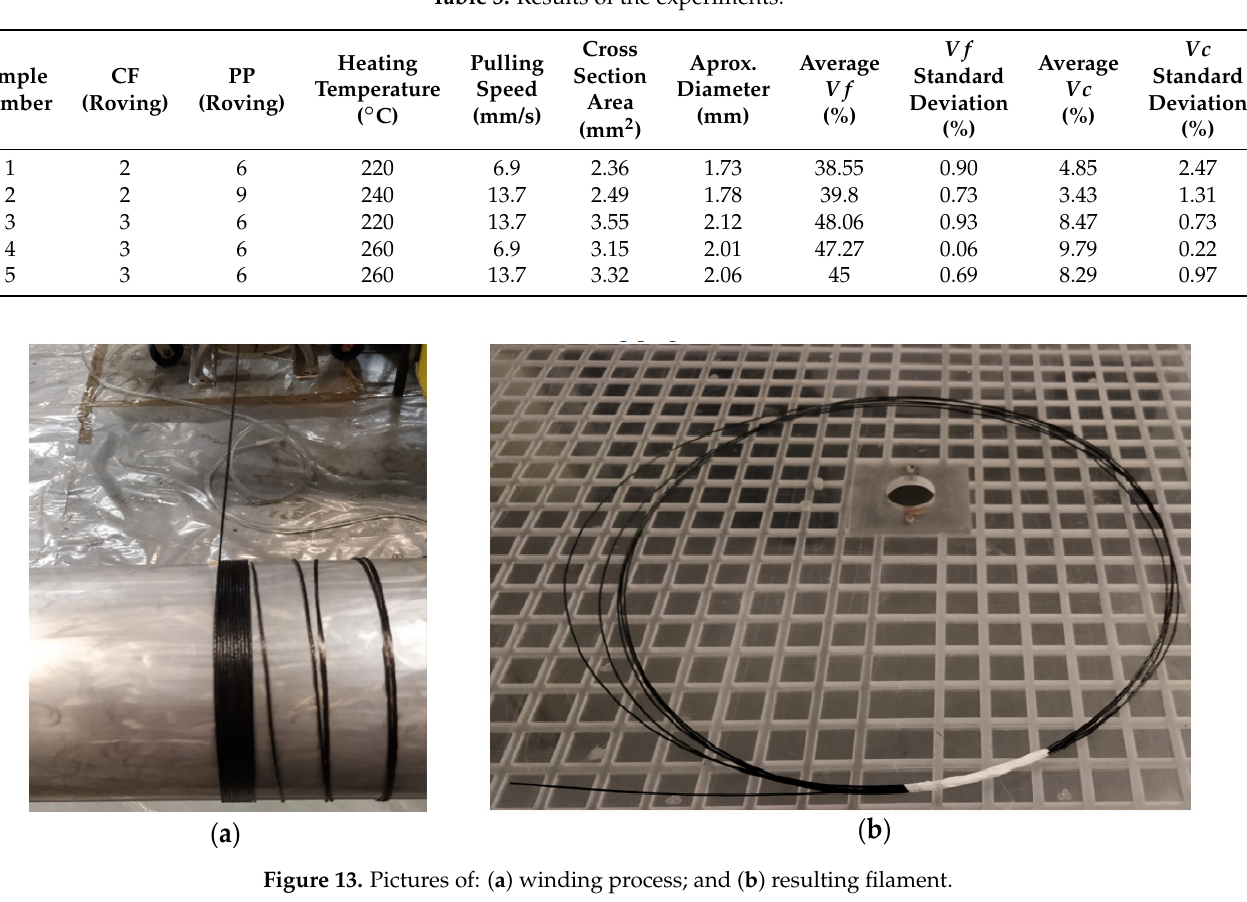
Table 3. Results of the experiments.